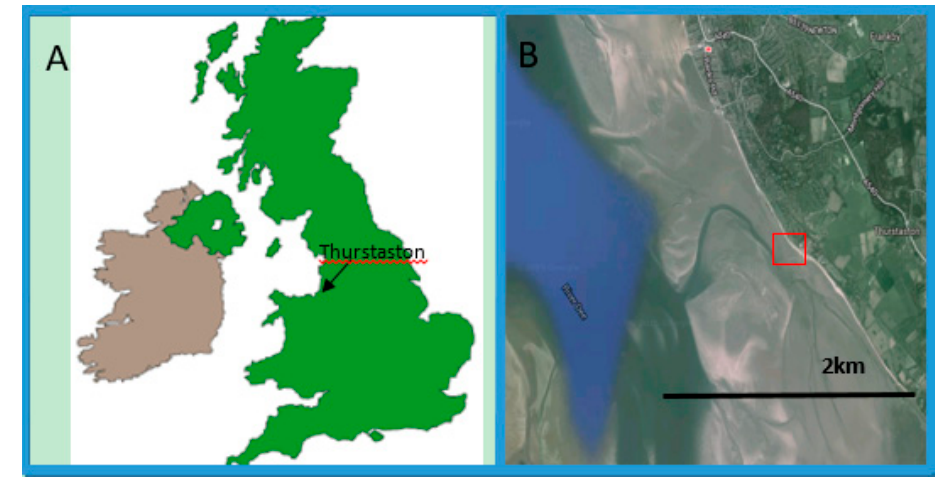
Figure 2. ( A ) Map of the United Kingdom with an arrow showing the location of the sample site; ( B ) an image of the River Dee estuary. The red box denotes the sampling site location that was used in this study